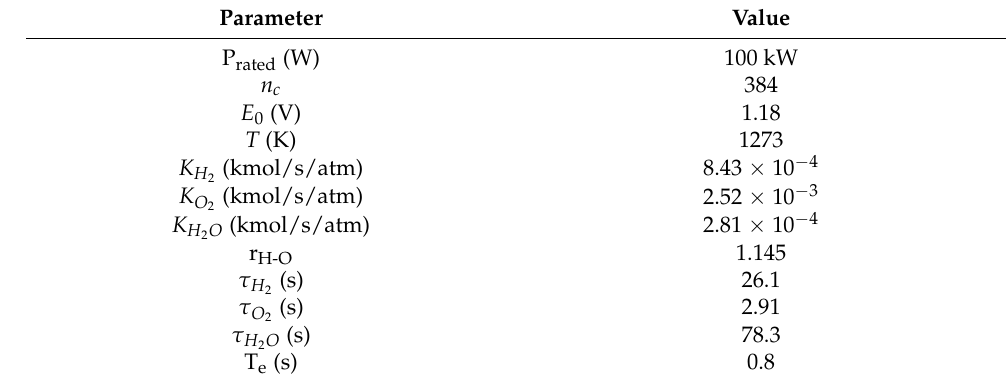
Table 6. SOFC stack specifications [30,31].